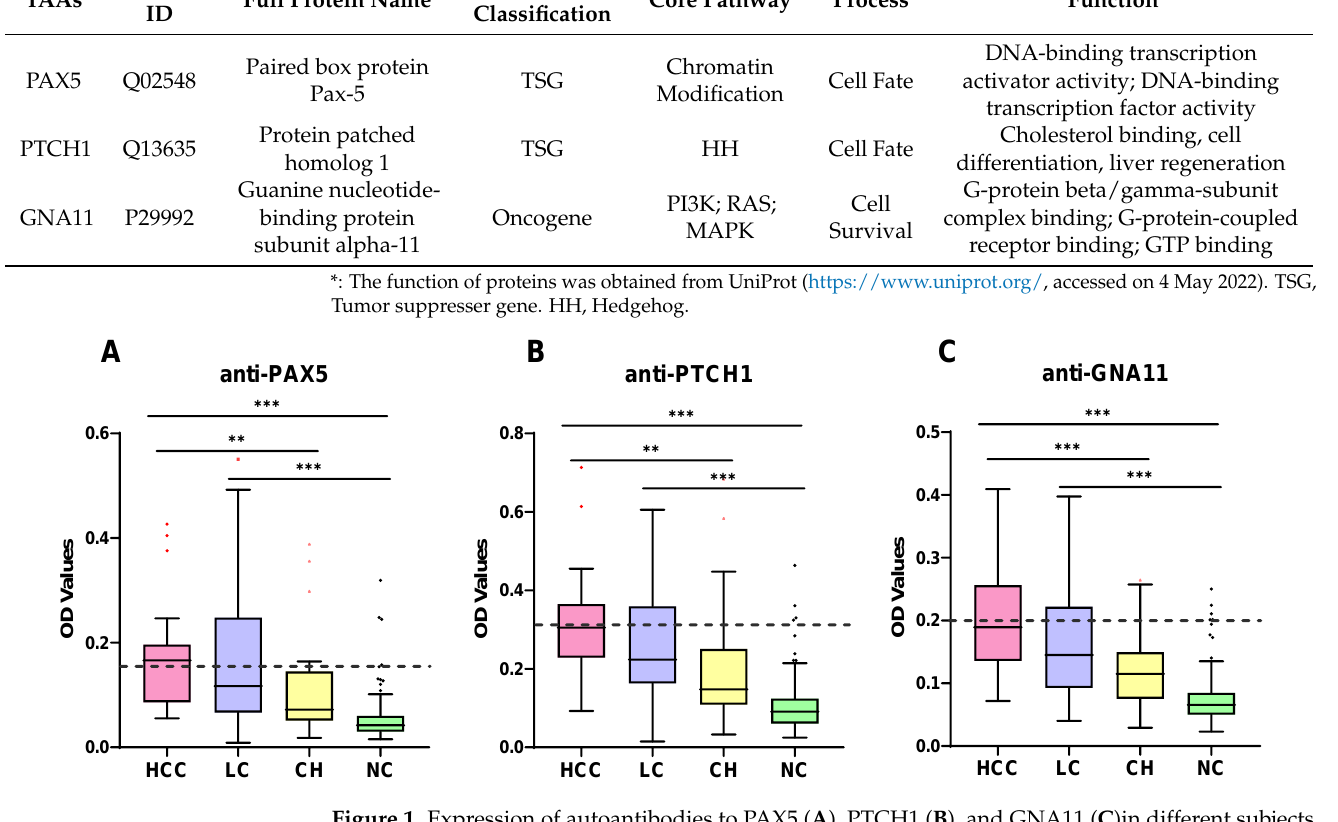
Table 1. Characteristics of PAX5, PTCH1, and GNA11.